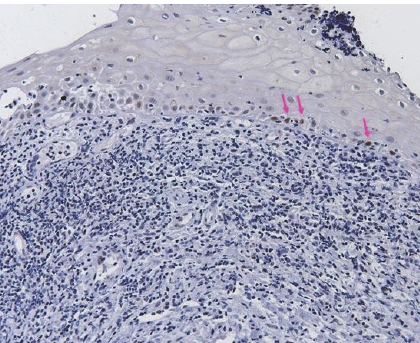
Figure 1: Normal region in the tumor margin. Arrows mark the immunoexpression of p53 in some focal areas in the basal layer with weak nuclear staining (200x Magnification).